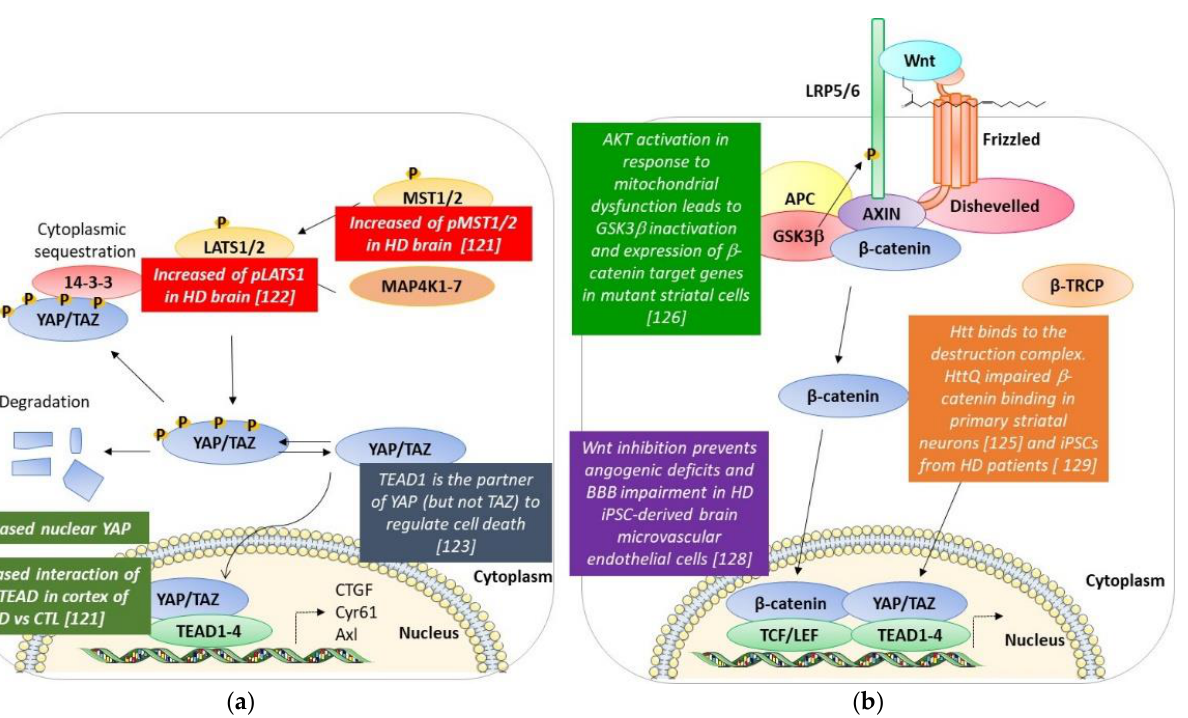
Figure 3. A schematic resume of the modifications of the Hippo and the Wnt pathways found in HD models and post-mortem HD brains. ( a ) Hippo pathway. ( b ) Wnt pathway. See text for details